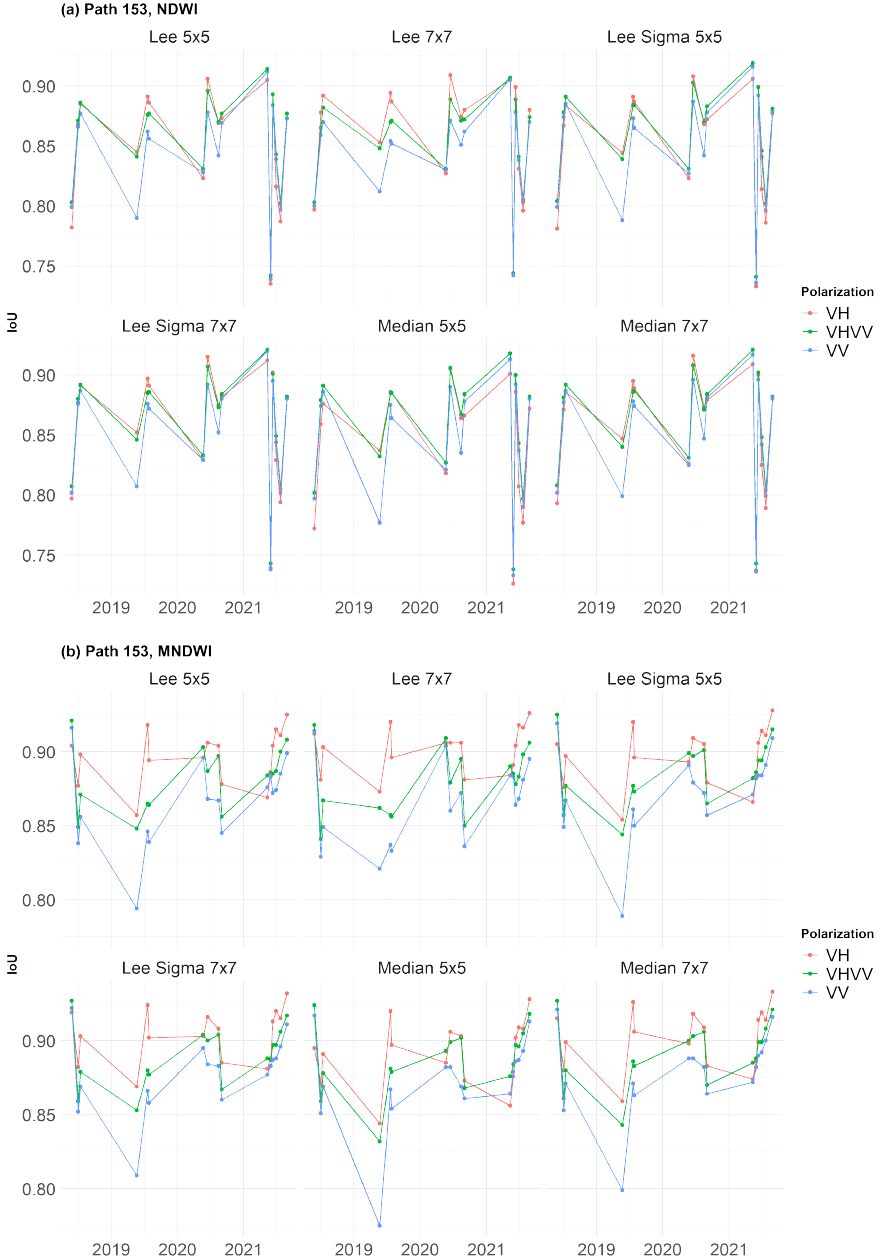
Figure 7. IoU -similarity plots over time for various polarizations and speckle filtering parameters: ( a ) path 153, NDWI and ( b ) path 153, MNDWI